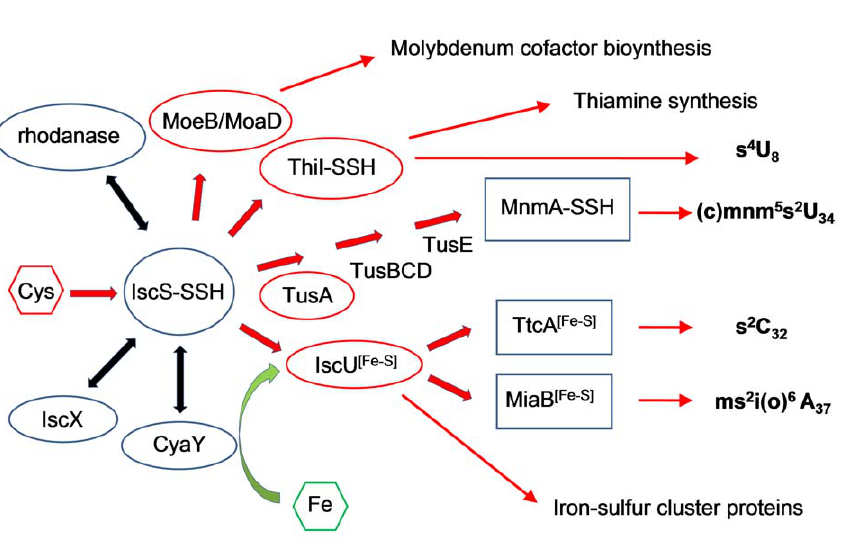
Figure 1. Network of protein-protein interactions involving IscS. IscS initiates intracellular sulfur trafficking, delivering the sulfur to several sulfur-accepting proteins such as IscU, ThiI, TusA, and MoaD/MoeB that commit the sulfur to different metabolic pathways. IscU is the primary scaffold for assembly of Fe-S clusters. Frataxin/CyaY has been postulated as an Fe chaperone, an Fe donor for Fe-S cluster assembly, or a regulator of Fe-S cluster formation. In the schematic, sulfur delivering is indicated by red arrows and IscS-interacting proteins are framed by ovals (red, in sulfur accepting proteins).